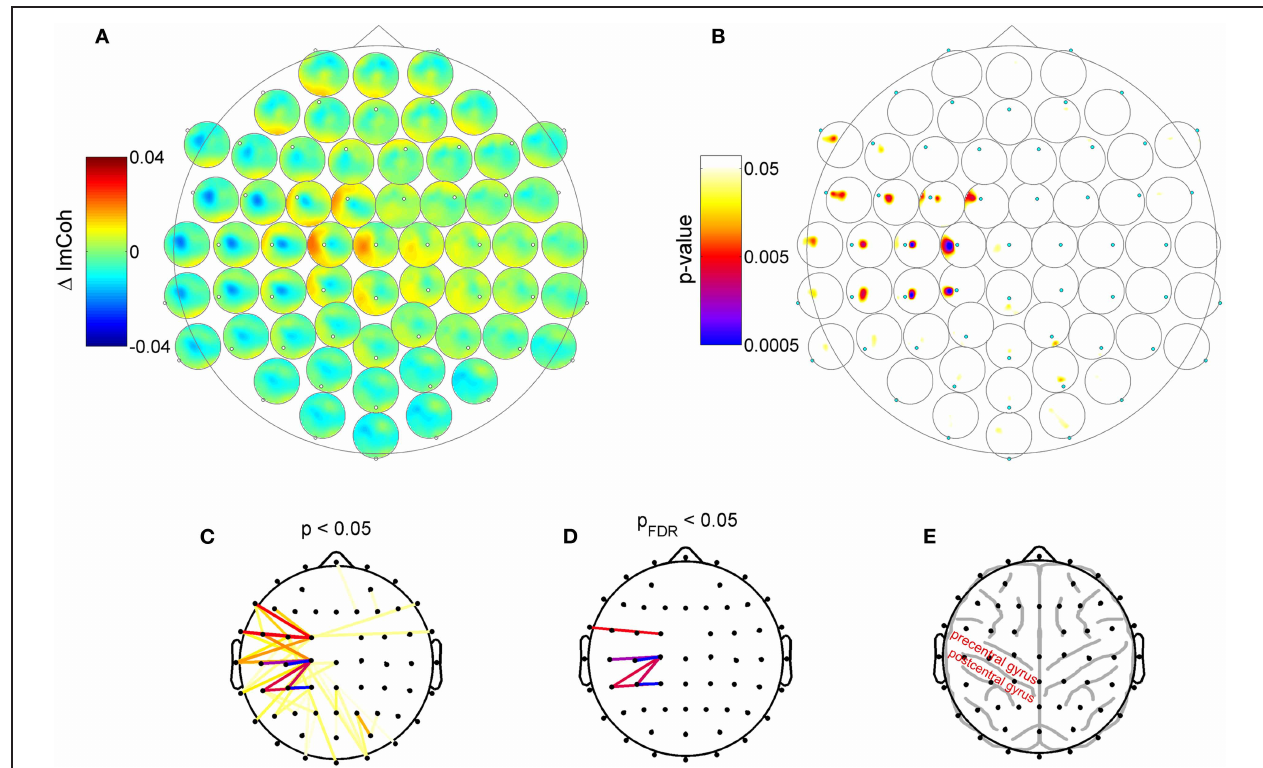
FIGURE 3 | Change of resting state functional connectivity after high-frequency RSS. (A) ImCoh difference between pre- and post- session (before and after RSS). Dots: Channel relative to which ImCoh is shown. (B) Corresponding p -values indicating statistically significant changes of ImCoh. A cluster of significant connectivity changes is located over contralateral central areas. (C) Different visualization of data shown in